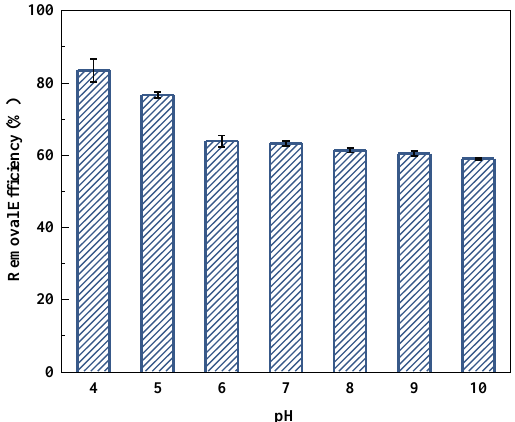
Figure 8. Effect of pH on the adsorption of HA onto RGO-SiO 2 .